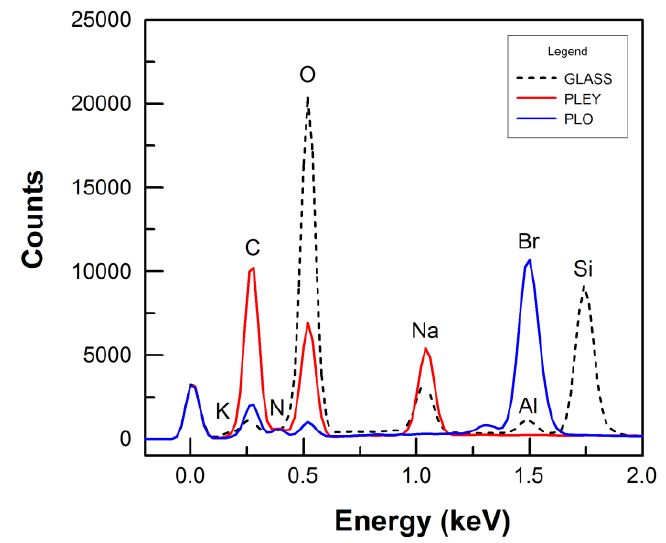
Figure 4. Energy-dispersive X-ray spectroscopic analysis of fibers. Spectra of glass, PLEY fibers on glass and PLO fibers on glass. Note the relative sizes of the oxygen, sodium and silicon peaks. The silicon peak occurs at ca . 1.8 keV. In the fibers samples, the silicon peak is lost in the noise; bare glass contributes relatively little to the measured values; the most prominent peaks are for carbon and oxygen (PLEY and PLO), sodium (PLEY) and bromide